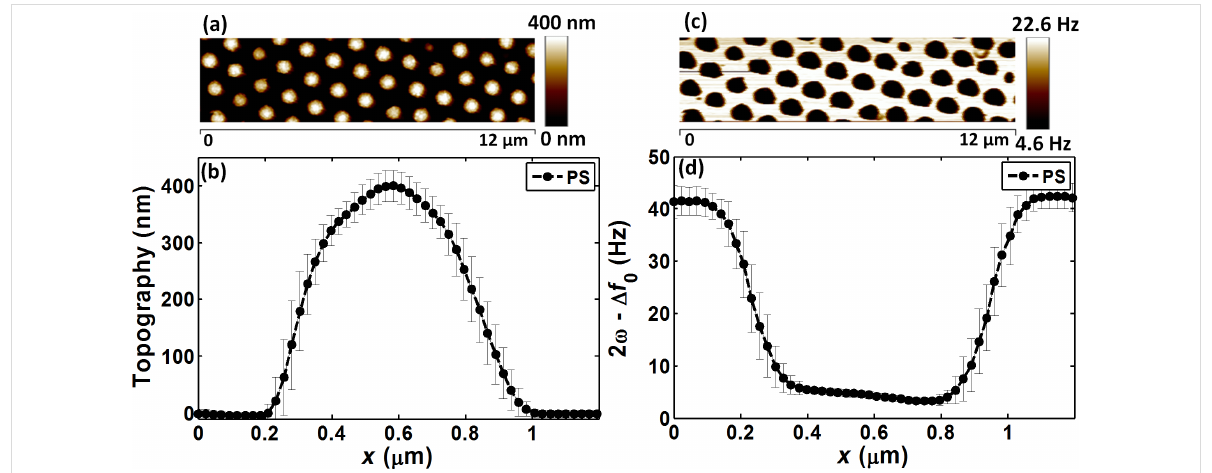
Figure 7: PS calibration – average cross-sectional profiles measured using a typical reference PS sample. (a) AFM image and (b) topography; (c) EFM image and (d) EFM response.